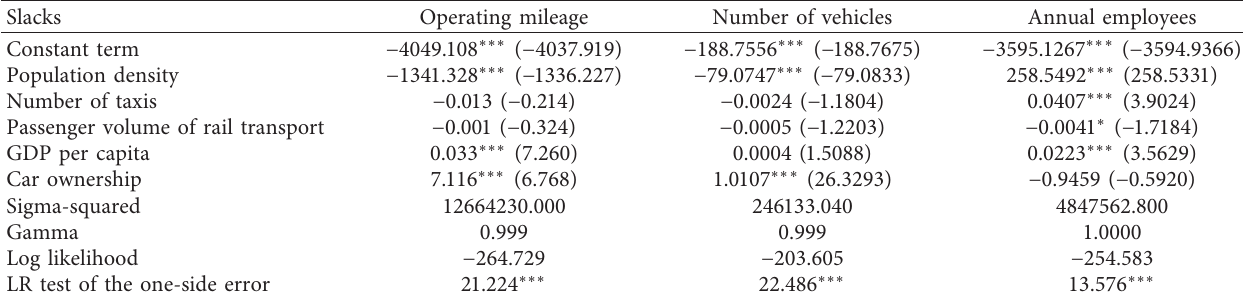
Table 4: SFA model parameters and estimation